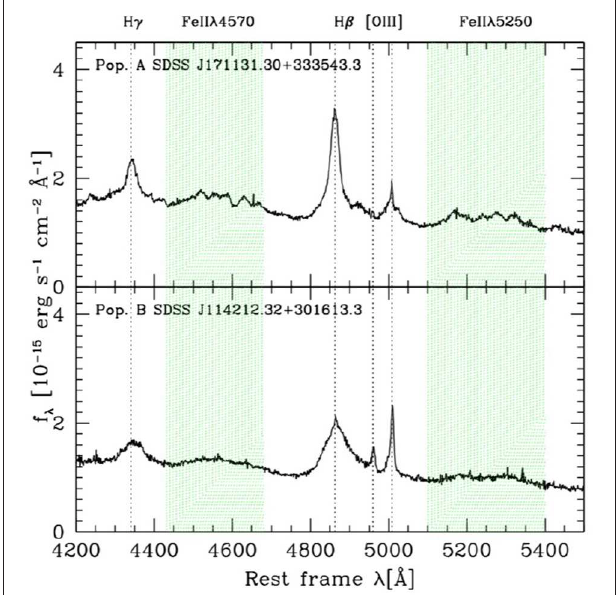
FIGURE 1 | The H β spectral range of two SDSS sources of Pop. A (top) and Pop. B (bottom). Abscissa is rest frame wavelength in Å, ordinate is specific flux in units of 10 − 15 ergs s − 1 cm − 2 Å − 1 . The shaded areas indicate spectral regions where the main emission line contribution is due to Fe II opt . On the blue side of H β the wavelength range of the shaded area defines Fe II λ 4570 i.e., the Fe II opt blended emission that is used to compute R FeII and to characterize Fe II opt prominence along the quasar eigenvector-1